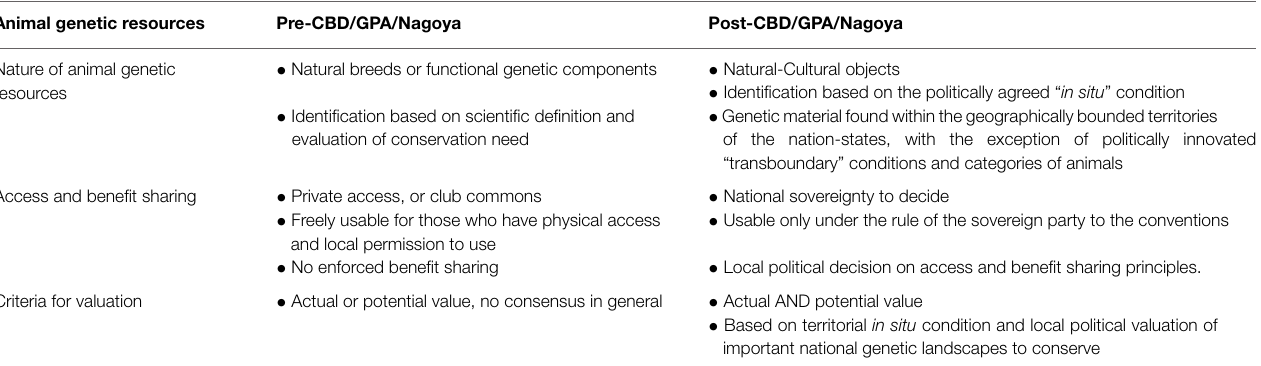
TABLE 1 | The historical changes in the value system for animal genetic resources. Animal genetic resources Pre-CBD/GPA/Nagoya Post-CBD/GPA/Nagoya Nature of animal genetic